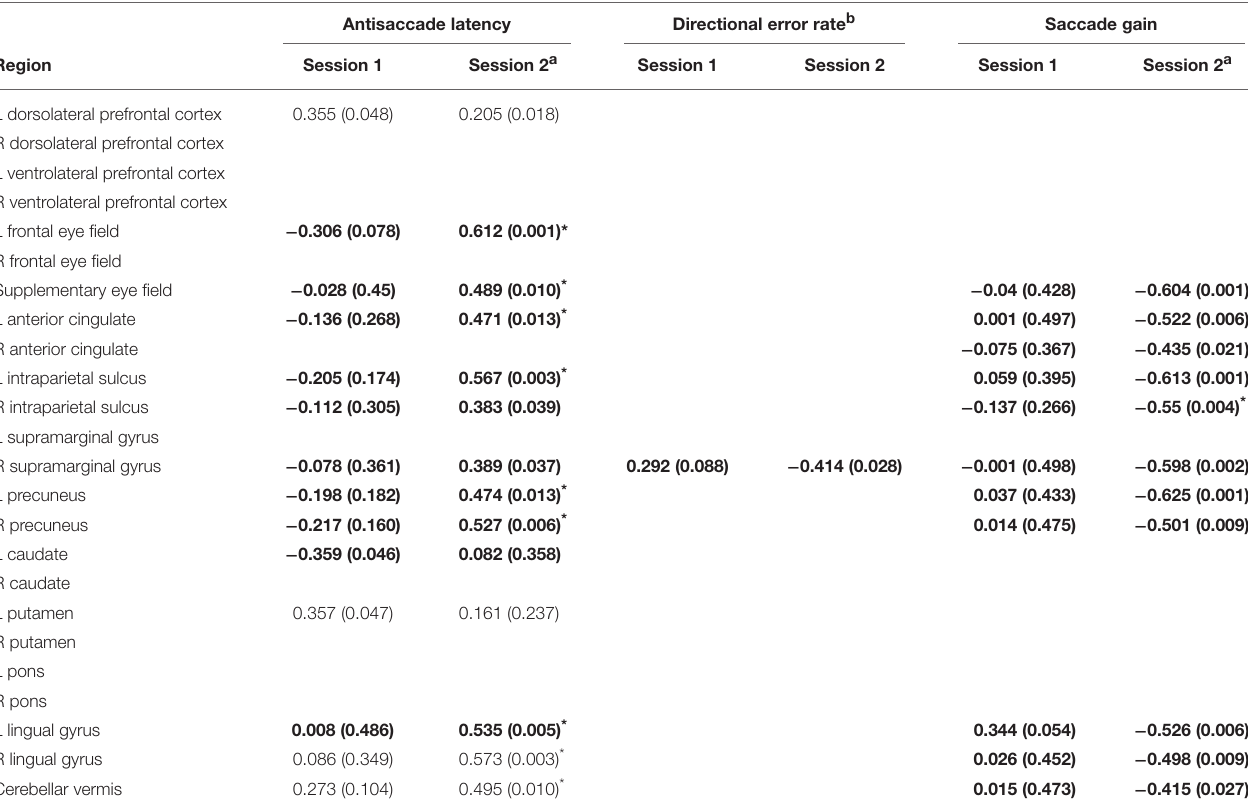
TABLE 4 | r -values ( p -values) for bivariate correlations between antisaccade regions of interest and behavioral